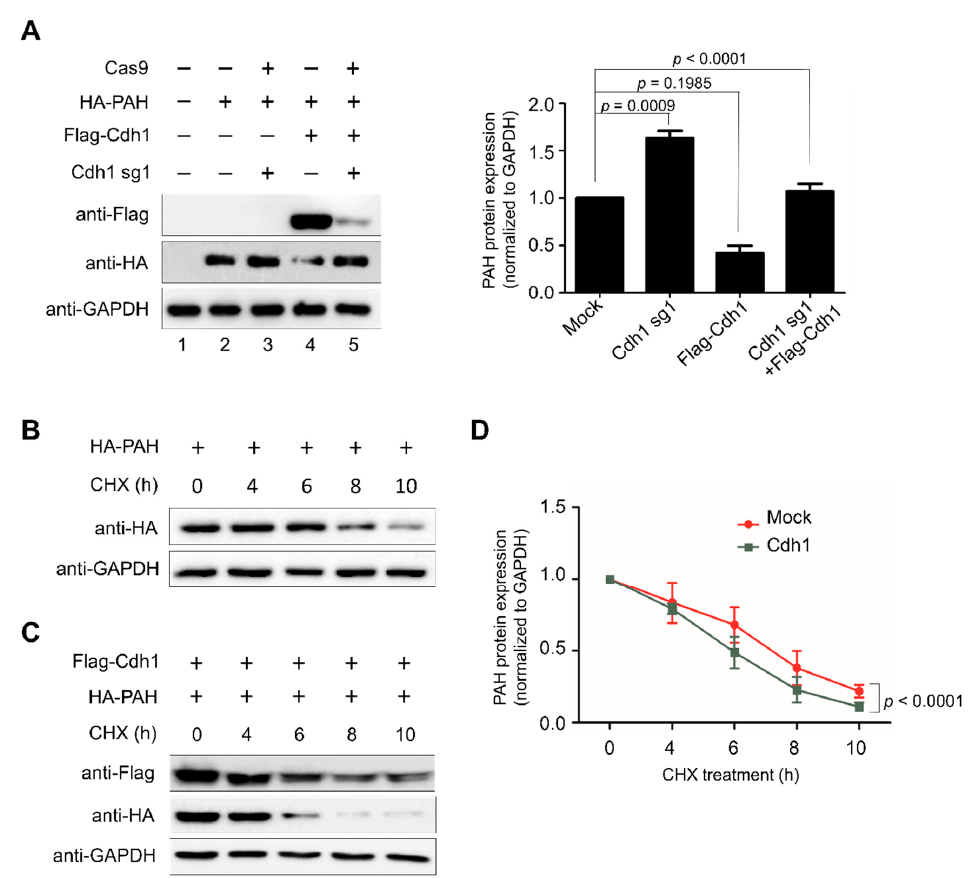
Figure 5. APC/C Cdh1 declines PAH protein half-life . ( A ) HA-PAH protein degradation mediated by Cdh1 was rescued upon depleting Cdh1. Protein expression was detected through indicated antibodies and analyzed by Western blotting. Band intensity was estimated using ImageJ software, normalized with GAPDH, and represented graphically. Data were presented as the mean and standard deviation of three independent experiments. One-way ANOVA followed by Tukey’s post hoc test was used, and p -values are indicated. ( B ) HEK293 cells were transfected with HA-PAH and treated with cycloheximide (CHX, 150 µ g / mL), harvested at di ff erent time points, and analyzed by Western blotting with the antibodies indicated. Band intensity was estimated using the ImageJ software, normalized with GAPDH, and graphically represented graphically. ( C ) HEK293 cells were transfected with HA-PAH in combination with Flag-Cdh1 and treated with cycloheximide (CHX, 150 µ g / mL), harvested at di ff erent time points, and analyzed by Western blotting with the antibodies indicated. ( D ) Band intensity of HA-PAH from both ( B , C ) was estimated using ImageJ software, normalized with GAPDH, and represented graphically. Data were presented as the mean and standard deviation of three independent experiments. Two-way ANOVA followed by Tukey’s post hoc test was used, and p -values are